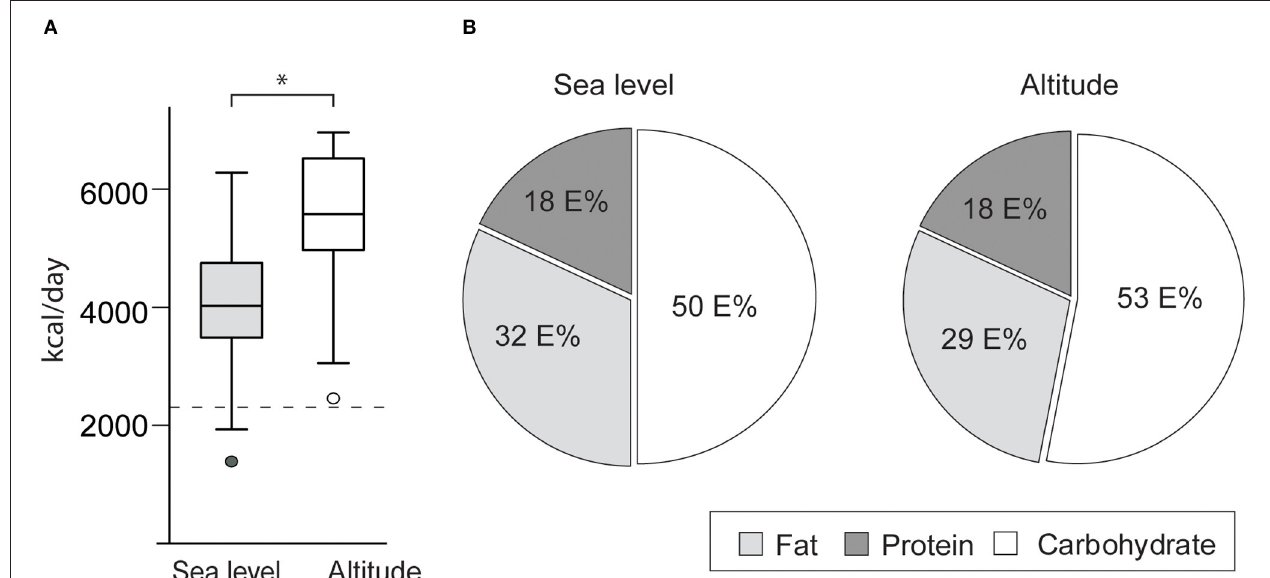
FIGURE 2 | Mean daily energy intake pre-altitude and at altitude (2,320m) in the whole population, with a dotted reference line to a healthy (non-athlete) Norwegian population (Totland et al., 2012) (A) , and mean energy contribution from carbohydrate, protein, and fat of the athletes’ diets pre-altitude and at altitude (B) . *indicates significant difference, p < 0.001. P -value is obtained from paired t